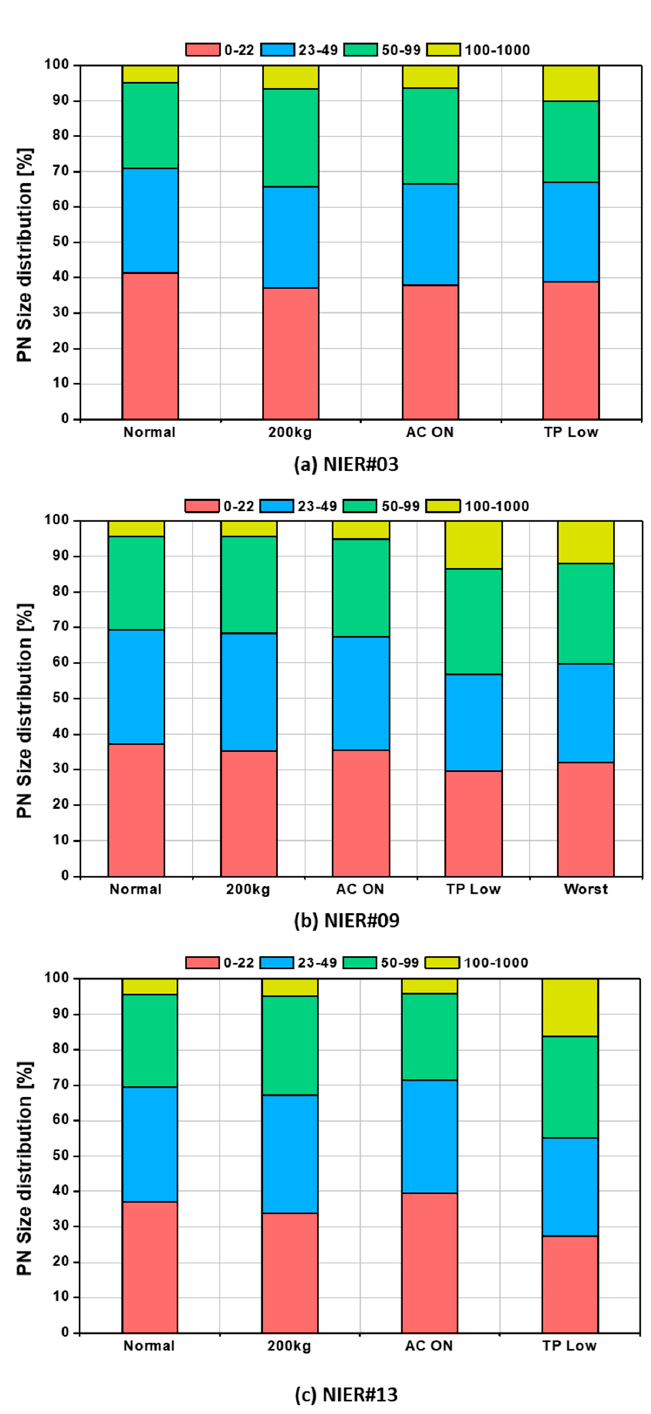
Figure 5. Size distribution of PN emissions with various driving conditions under NIER testing modes; red bar indicates PN size ranged 0 to 22 nm, blue bar indicates 23 to 49 nm, green bar indicates 50 to 99 nm and yellow bar indicates PN sized over 100 nm.